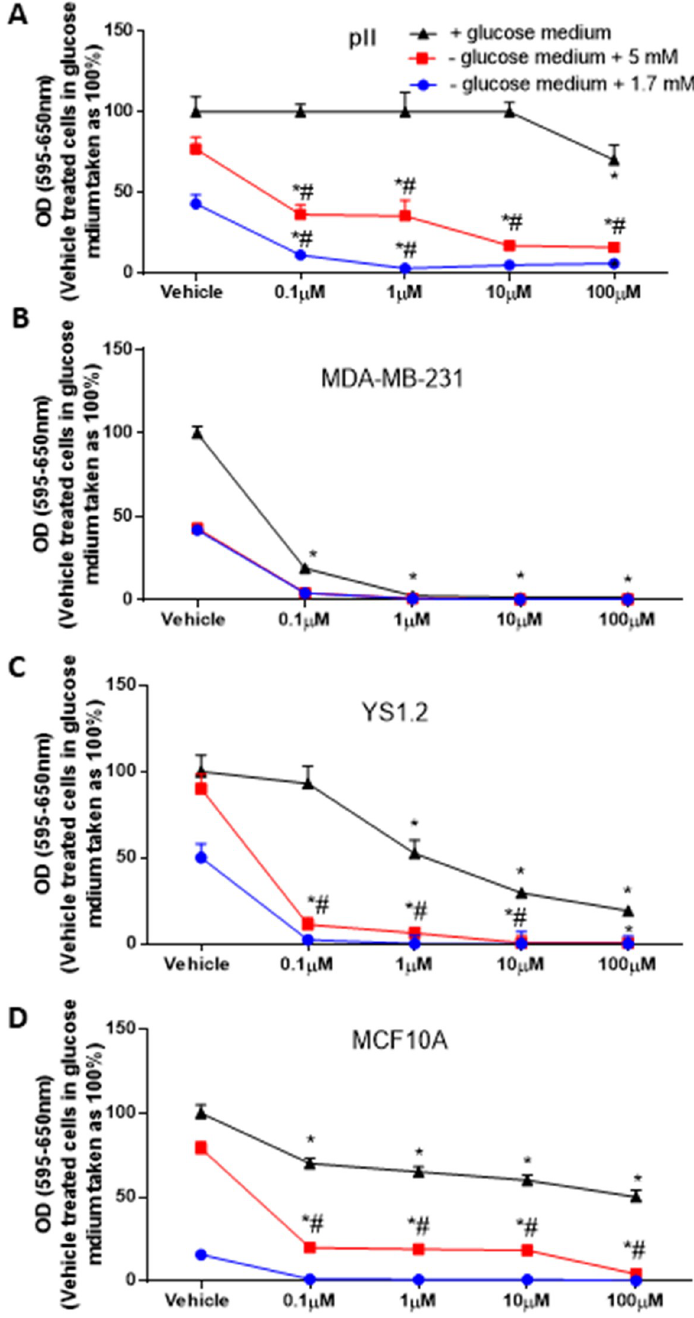
Fig 9. Effect of glucose depletion on the anti-proliferative effects of doxorubicin in breast cancer cell lines. The effect of doxorubicin on cell proliferation upon culture in +glucose medium (black line, taken as 100%) or—glucose medium plus 5 mM (red line), or 1.7 mM glucose (blue line) was determined at day 4 using the MTT assay. Histobars represent means ± SEM of at least 3 independent determinations. � denotes significant difference from cells treated with vehicle (normal saline), with p <